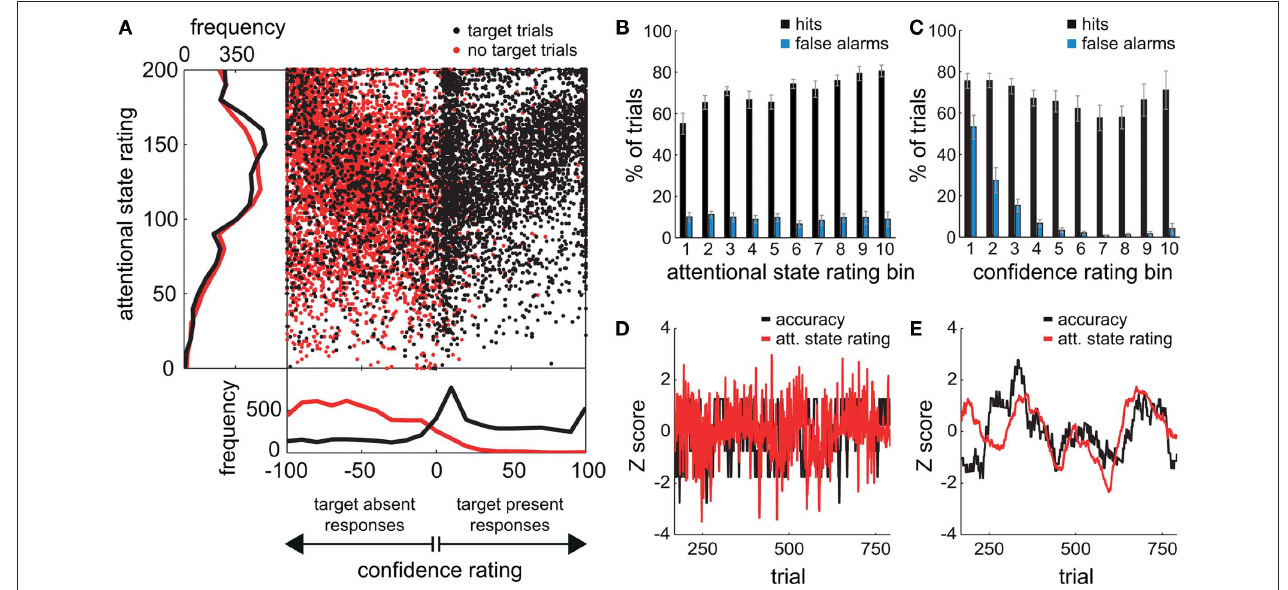
percentages of hits and false alarms as a function of attentional state rating decile and confidence rating decile, respectively. Error bars show the SE of the mean across participants. (D) The normalized time series of attentional state ratings (red line) and detection task accuracy (black line) for one participant. (e) The normalized time series of attentional state ratings (red line) and detection task accuracy (black line) for one participant after smoothing each time series with a sliding window size of